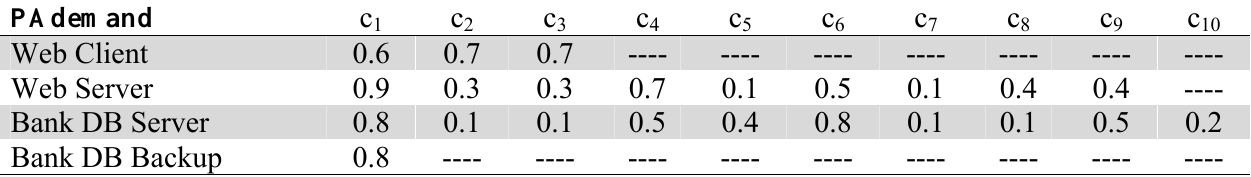
The label PAdemand values for